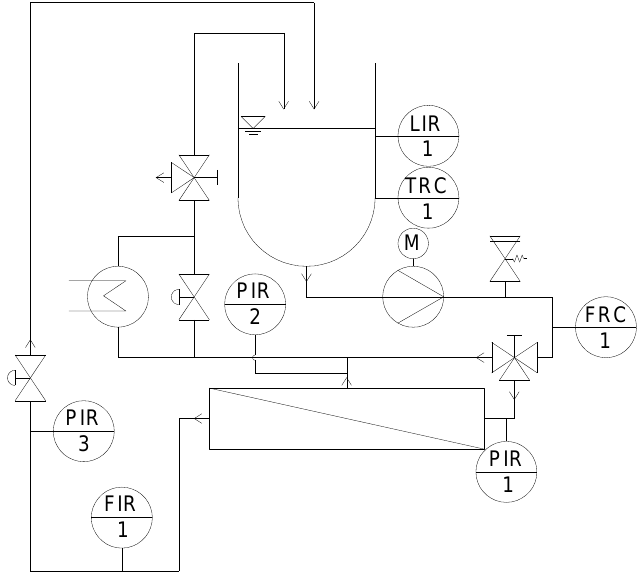
Figure 1. Simplified piping and instrumentation (P&I) diagram of the pilot plant for the investigation on 6338 spiral-wound membranes (SWMs) (modified according to [46]).